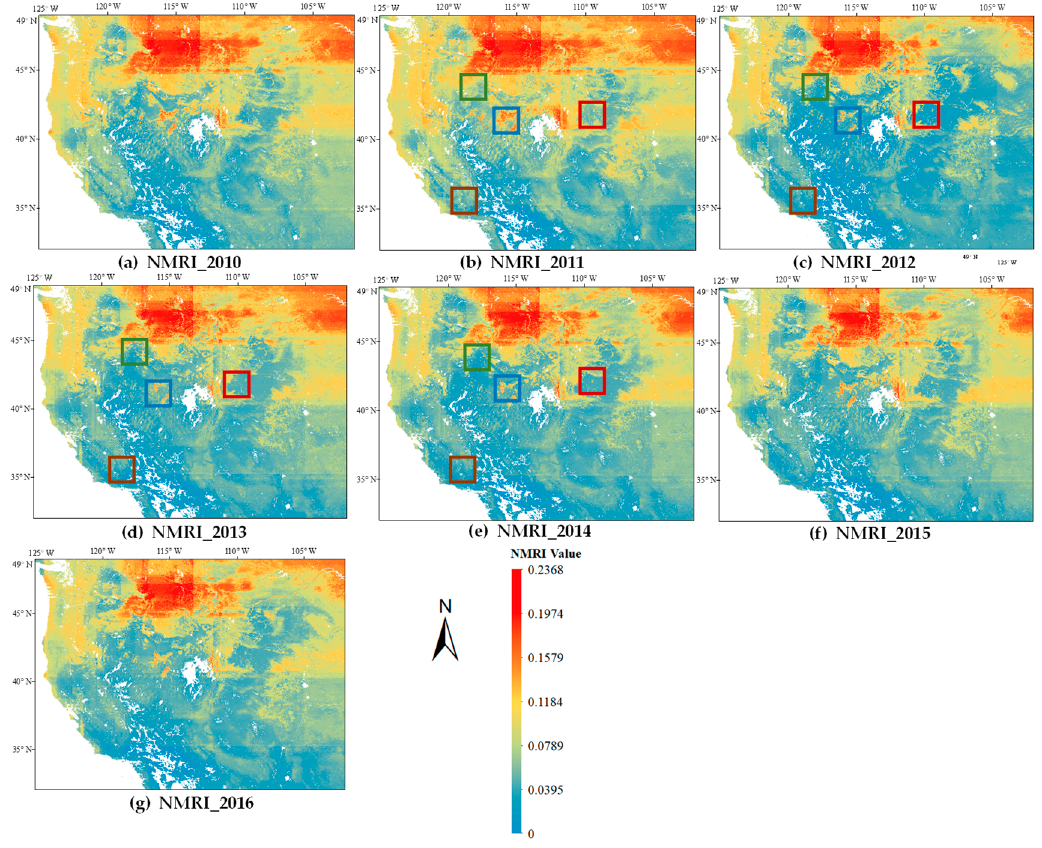
Figure 14. 500 m NMRI maps in July from 2010 to 2016.